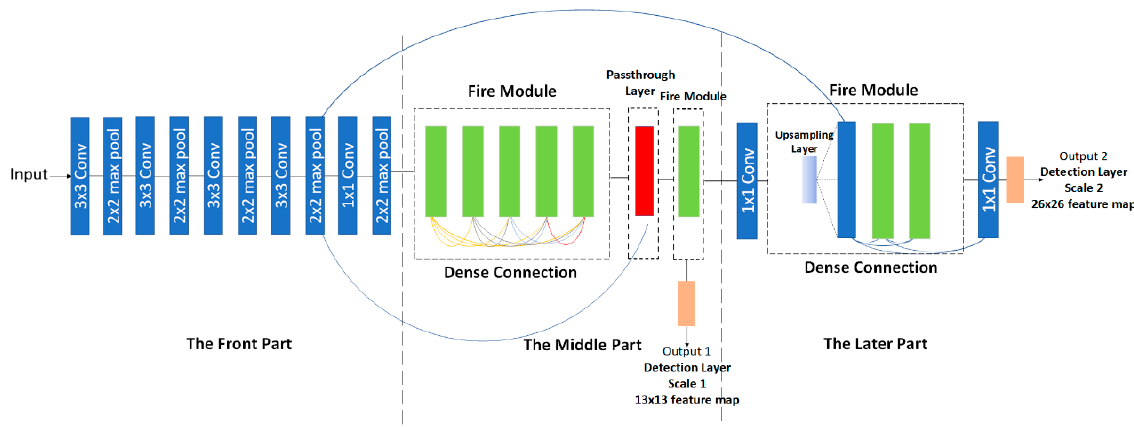
Figure 5. The structure of Tinier-YOLO.